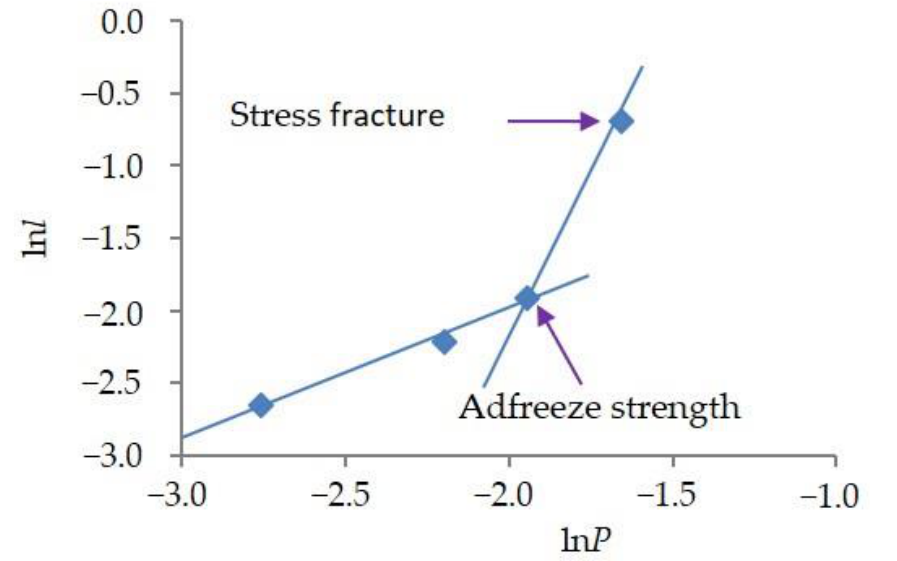
Figure 6. Adfreeze strength in the loading force ( P ) vs. strain ( l ) plot. Axles are in the «ln» scale. Dotes are experimental data, lines are approximations.